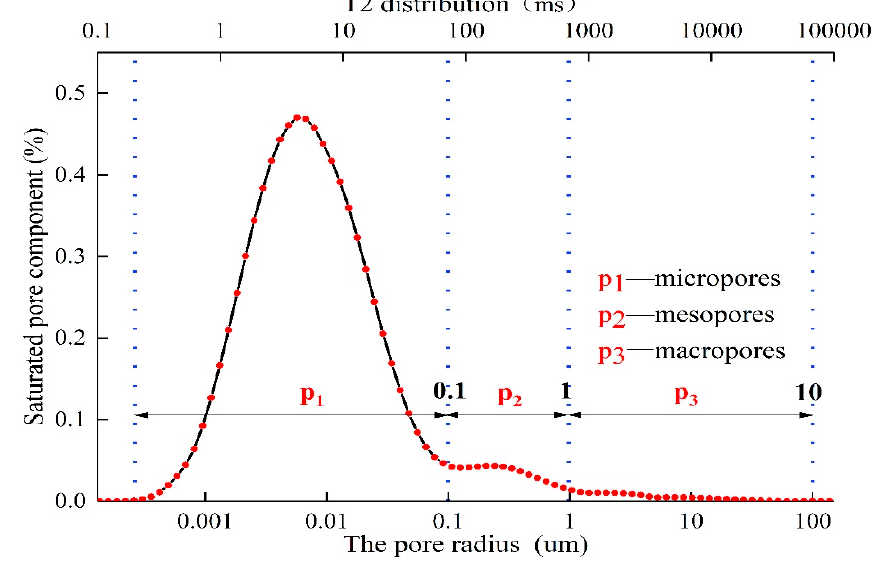
Figure 2. Dividing the pore size of sandstone materials.